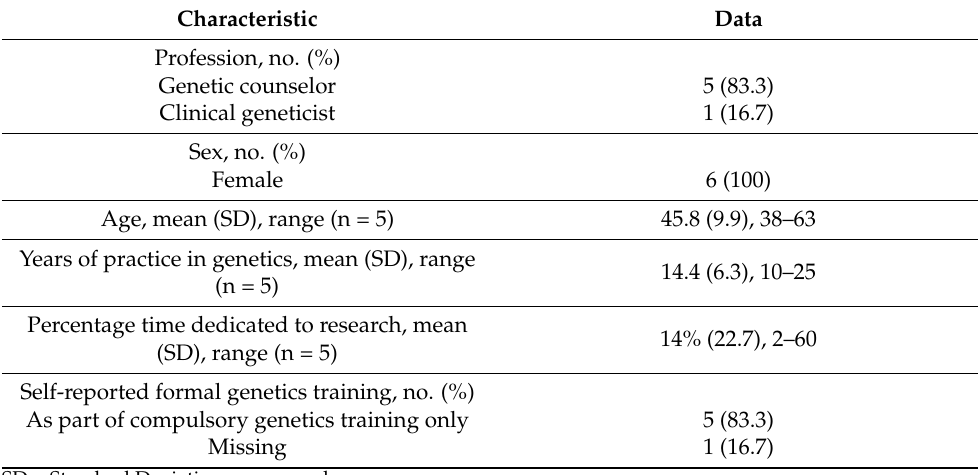
Table 2. Demographics, genetics professionals (n = 6).